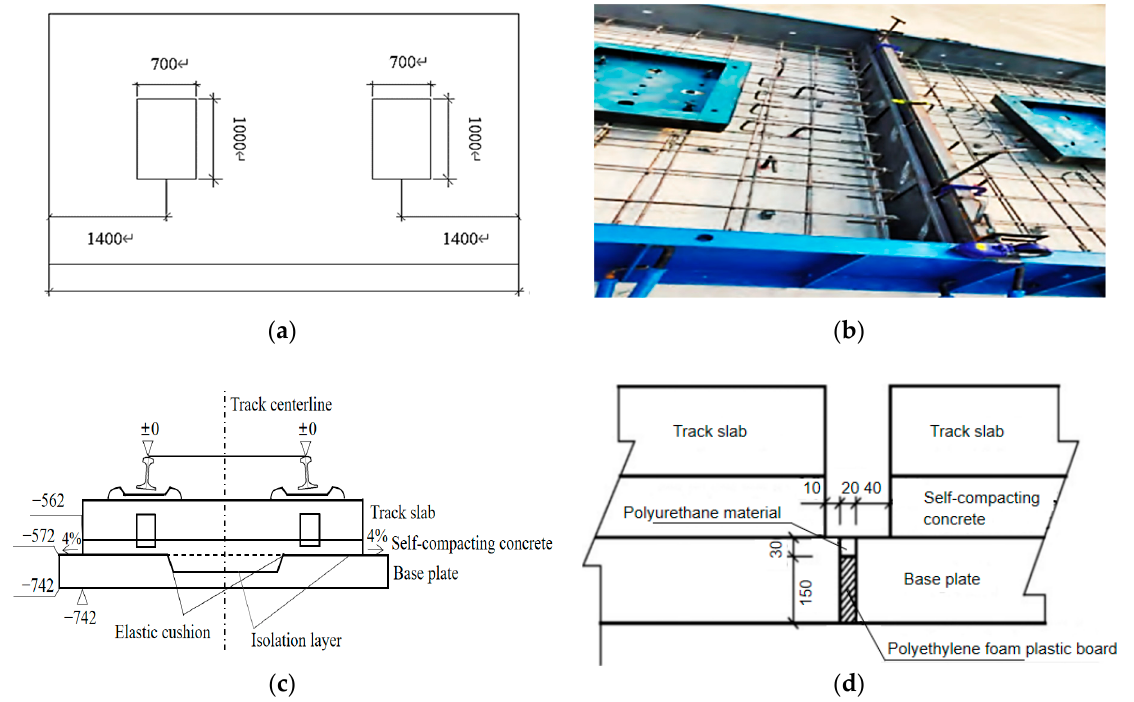
Figure 1. Schematic and substructure diagram of CRTSIII SBT. ( a ) Size of base plate; ( b ) schematic diagram of internal reinforcement; ( c ) lateral section; ( d ) longitudinal section.